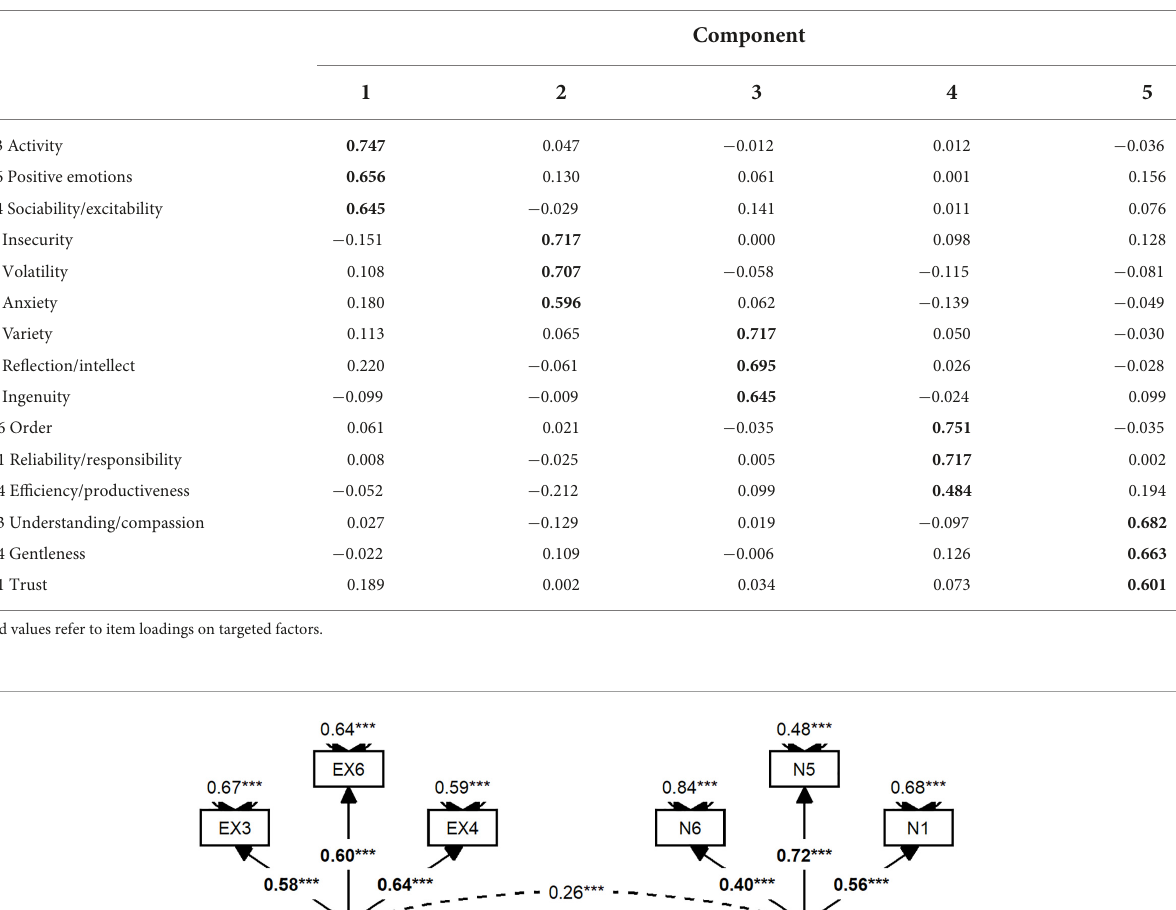
TABLE 3 A principle components solution with the 15 highest-loading items on targeted factors.